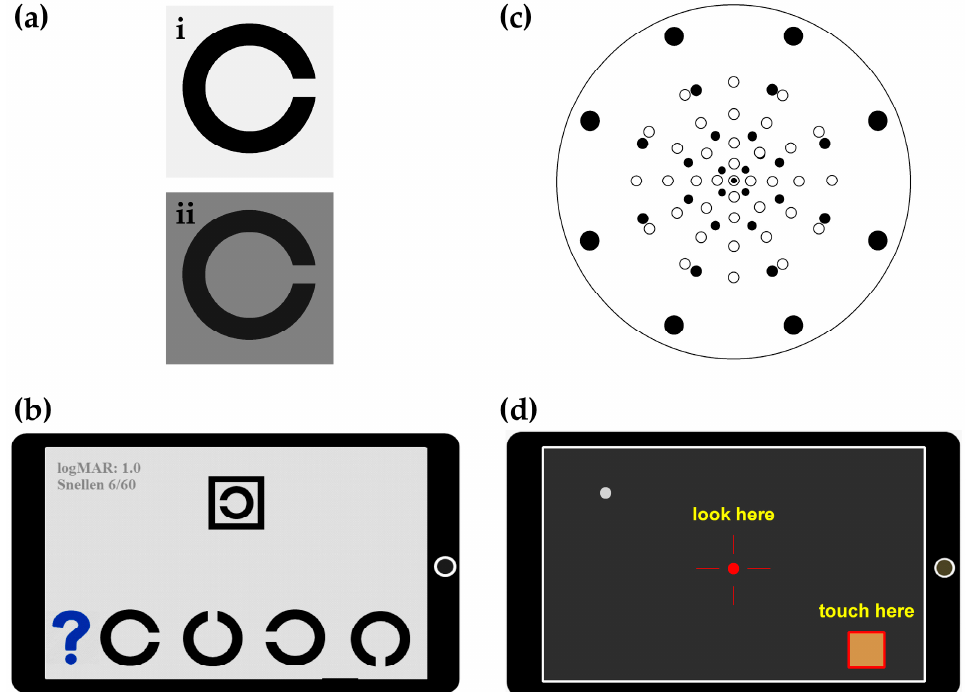
Figure 1. The Melbourne Rapid Fields vision testing application. ( a ) The visual acuity Landolt C targets. ( i ) High contrast visual acuity (HVA, L b : 135 cd/m 2 , contrast: 94%). ( ii ) Low-luminance visual acuity (LLVA, L b : 5 cd/m 2 , contrast: 86%). ( b ) Patients adopt a 4-alternate-forced-choice to identify the orientation of the target shown in the central box. ( c ) Visual field protocol. Unfilled circles represent MAIA test spot locations and filled circles denote the MRF grid. Note size scaling of MRF stimuli occurs away from fixation. Black ring is 10° eccentricity. ( d ) The visual field task. App-generated audio prompts instruct participants to look at the red fixation cross and tap in the designated ‘touch zone’ when a stimulus is observed.